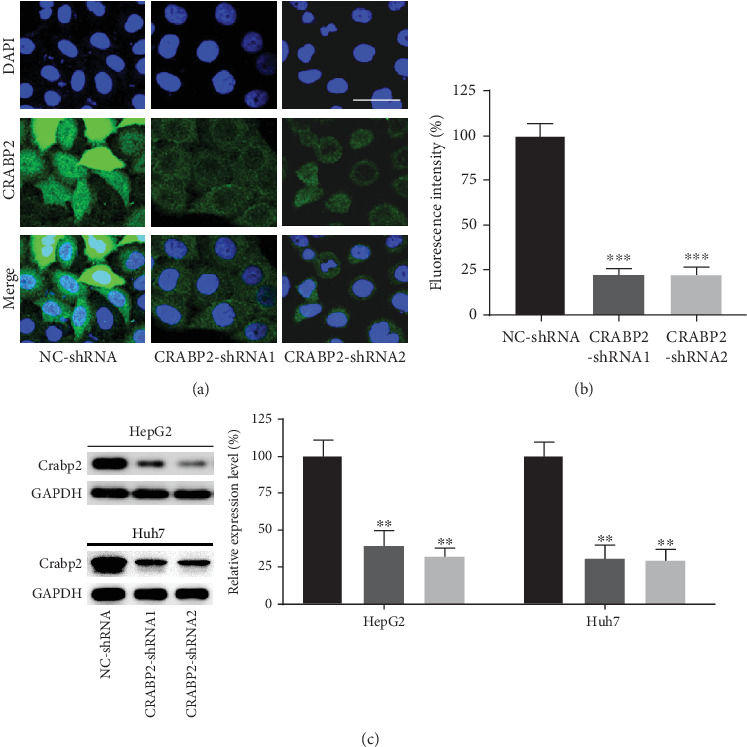
CRABP2 expression decreased after CRABP2-shRNA transfection. (a) CRABP2 expression was analyzed by immunofluorescence staining in HpeG2 cells transfected with shRNAs. (b) CRABP2 expression was quantified by immunofluorescence intensity. n = 8. (c) Western blotting was applied to determine the protein expression of CRABP2 in HpeG2 cells after shRNA transfection. n = 8. One-way ANOVA was used in multigroup comparison. Scale bar = 20 μm. All data are presented as mean ± SEM. ∗∗P < 0.01 vs. NC-shRNA.